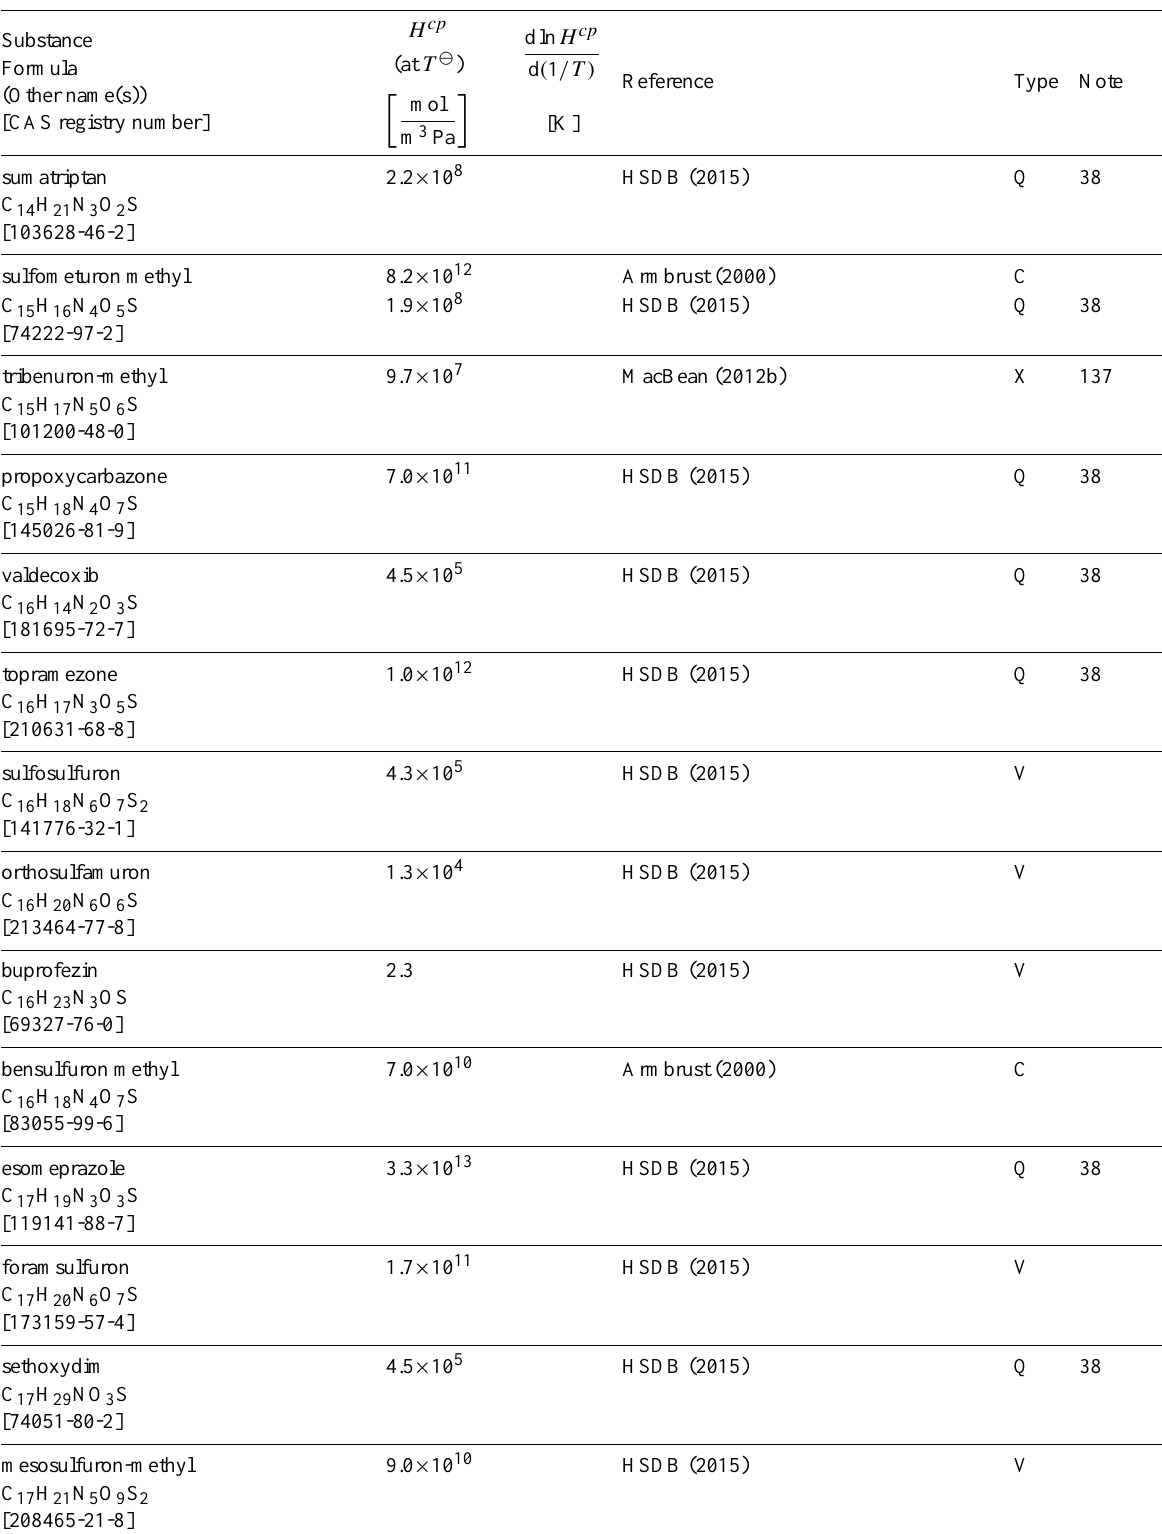
Table 6: Henry’s law constants for water as solvent